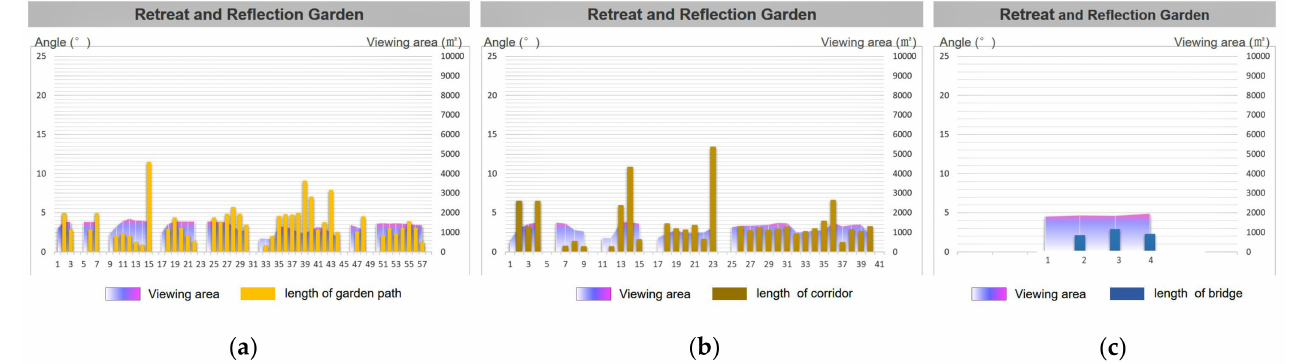
Figure 10. The Retreat and Reflection Garden: overlay map of unilateral length and viewshed area of garden road turns. ( a ) The garden path length and viewing area; ( b ) the corridor length and viewing area; and ( c ) the bridge length and viewing area.